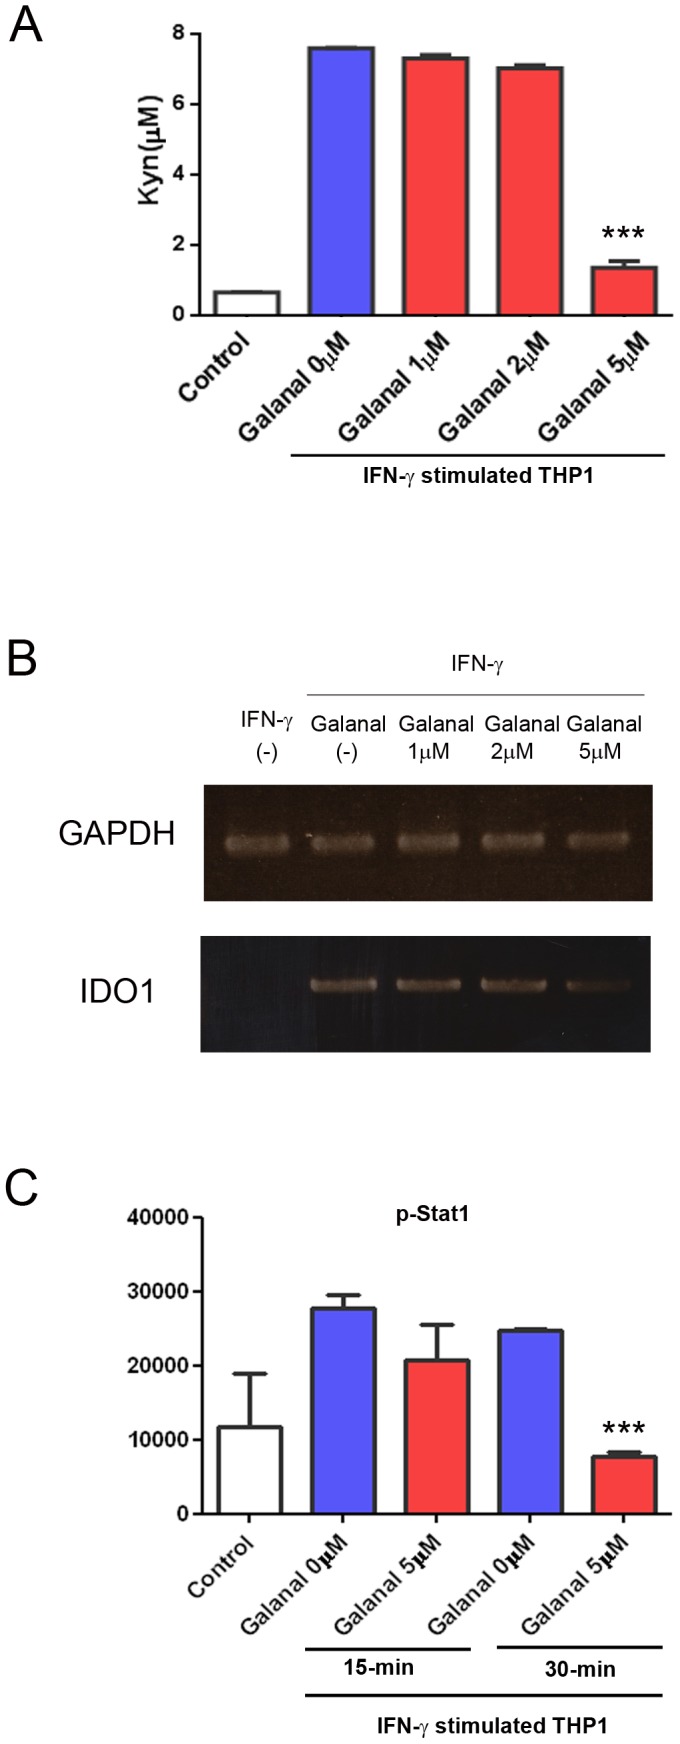
Inhibition by galanal of the IFN-γ dependent pathway.(A) L-Kyn formation in IFN-γ (100U)-treated THP-1 cells with and without various concentrations (1-5 µM) of galanal. L-Kyn formed after 24-hr incubation was measured by HPLC. Data are the mean ± SD. ***P<0.001. (B) Expression of IDO1 mRNA in IFN-γ (100 U)-treated THP-1 cells with and without galanal (1-5 µM) after 24-hr incubation. IDO1 mRNA expressed in IFN-γ -treated THP-1 cells with and without galanal was measured using RT-PCR. (C) The phosphorylation of stat1 in IFN-γ (100 U)-treated THP-1 cells with and without galanal after 15-min or 30-min incubation. n. Data are the mean ± SD. ***P<0.001.